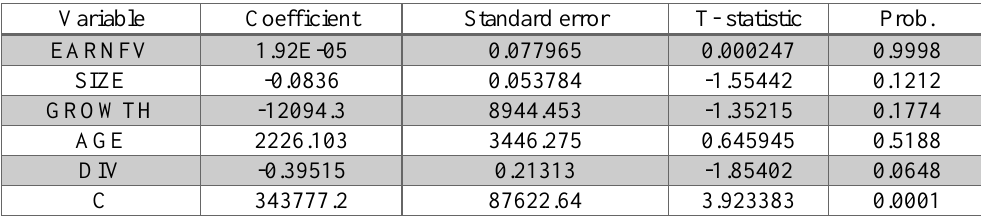
Table 3 . Results of fixed effects- Model Number